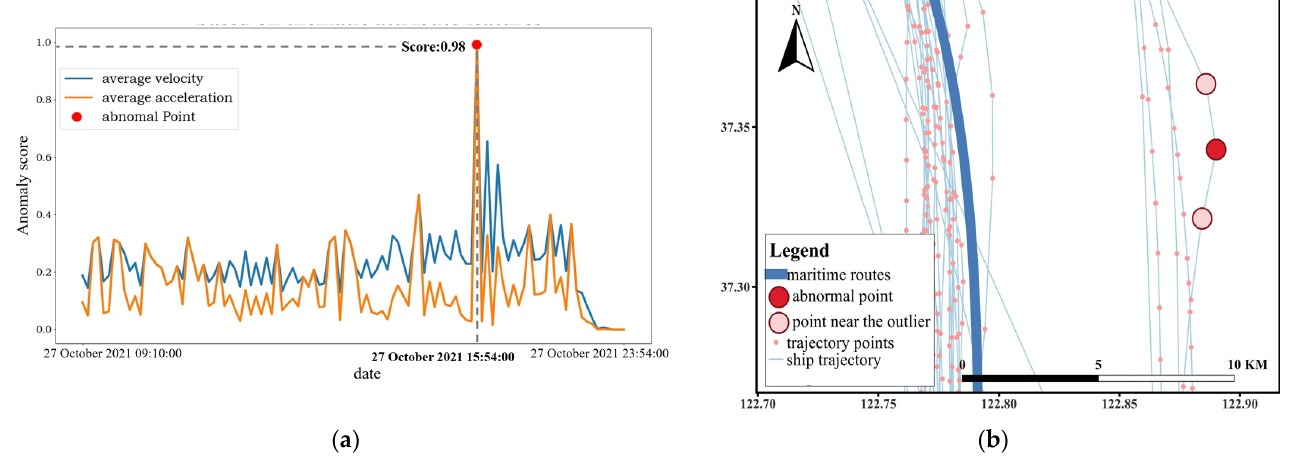
Figure 18. The thematic attribute set is the schematic diagram of abnormal ship point detection with average characteristics. ( a ) The changes in the average speed and average acceleration of the ship. ( b ) The realistic mapping of the high anomaly score points in ( a ) in the geographic